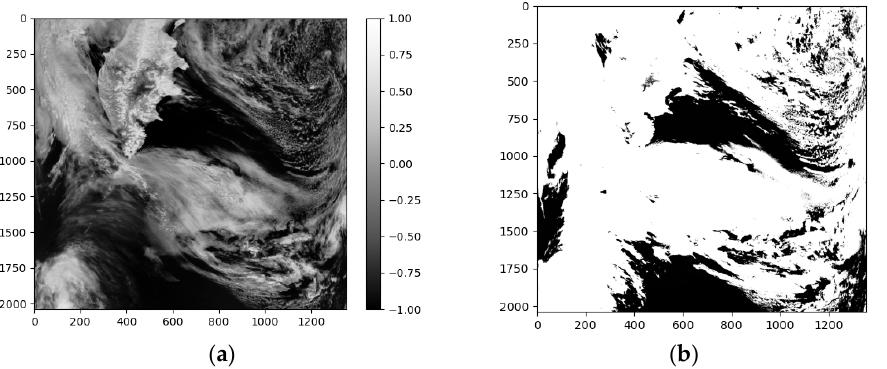
Figure 4. ( a ) A region of visible ‐ light band image. ( b ) The image after Normalized Detection Index